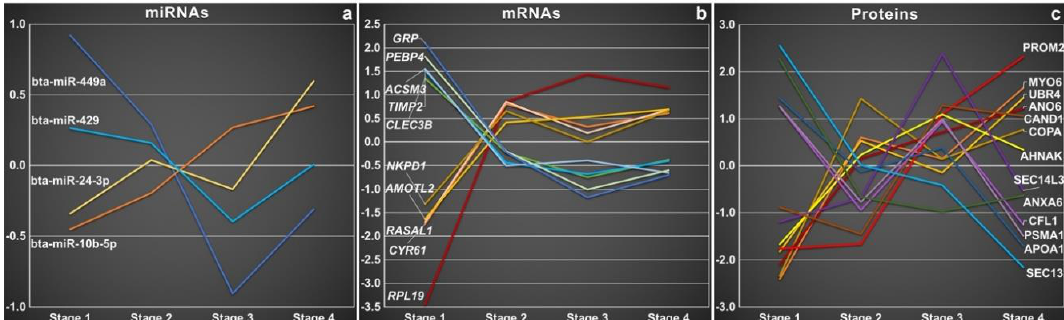
Figure 3. Profiles of miRNAs, mRNAs, and proteins during the estrous cycle in bovine oviductal extracellular vesicles (oEVs). MicroRNAs ( a ), mRNAs ( b ), and proteins ( c ) showing the most pronounced and representative changes with respect to typical expression profiles during the estrous cycle in oEVs were selected. Similar profiles are shown in related colors. Relative expression is shown as mean-centered expression values (log2-transformed expression value of the stage minus mean of all 4 stages). Stage 1: recently ovulated follicle (days 1 – 4 post-ovulation (po)); stage 2: early luteal development with medium or large follicles or both present (days 5 – 11 po); stage 3: fully functional corpus luteum (CL) yellow or orange in color (days 11 – 17 po); stage 4: regressing CL with little vasculature and a large preovulatory follicle present (days 18 – 20 po).